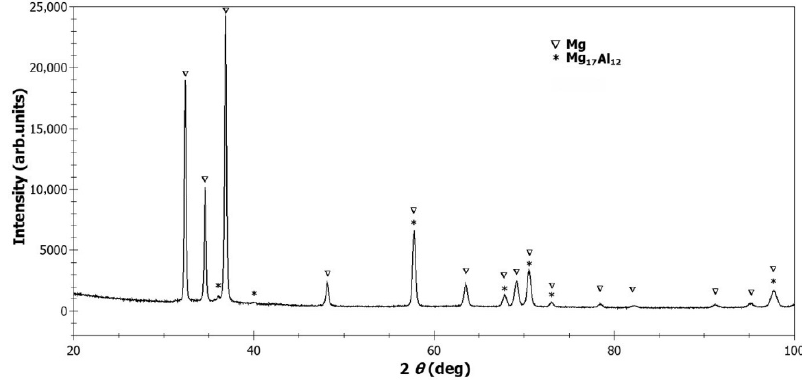
Figure 1. XRD pattern of AZ61–10 wt.% Al 2 O 3 nanocomposite indicating the occurrence of Mg matrix and Mg 17 Al 12 intermetallic phase.